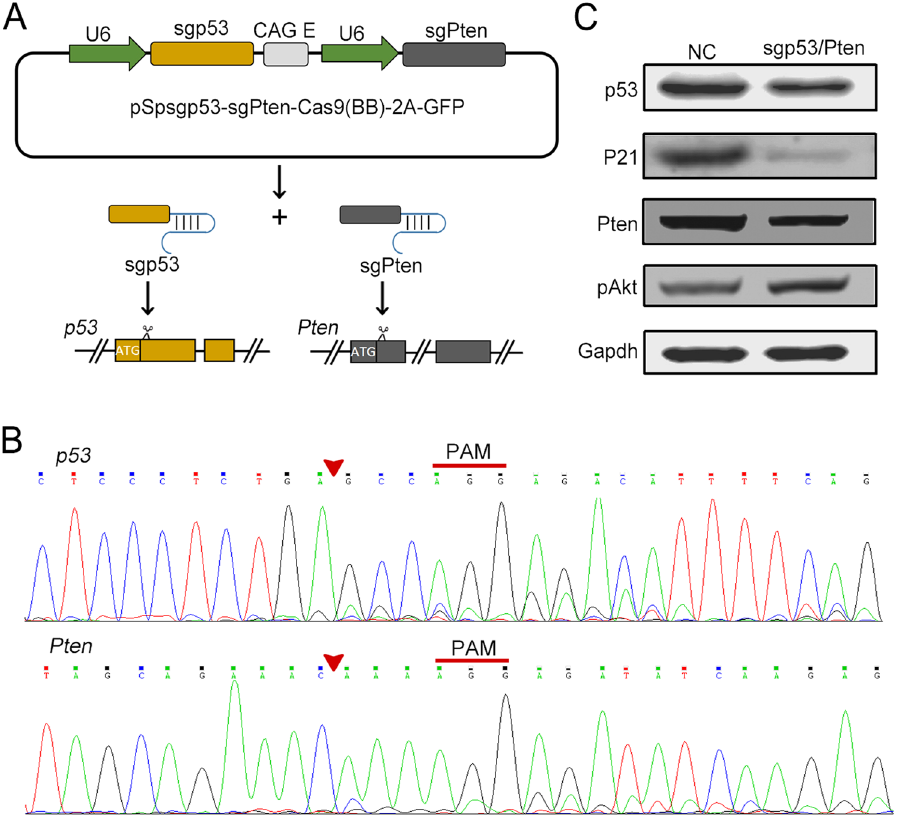
Figure 1. Dual sgRNA cassette induced loss-of-function alterations of p53 and Pten genes in H2.35 cells. ( A ) Schematic for the dual sgRNA expressing cassette containing both p53 -specific sgRNA and Pten -specific sgRNA. ( B ) Indel mutations of p53 and Pten identified by sequencing in the sgp53/Pten dual cassette transfected cells. H2.35 cells were transiently transfected with dual sgRNA cassette plasmids. Forty-eight hours later, cellular genomic DNA in H2.35 cell pools were extracted and PCR sequencing assays were performed to analyze the indel mutations of p53 and Pten . Red triangles indicate the predicted DNA cleavage sites. The proto-spacer adjacent motif (PAM) sequences were denoted by red lines. ( C ) Loss-of-function alterations of p53 and Pten genes detected by Western blot assay. Gapdh was used as